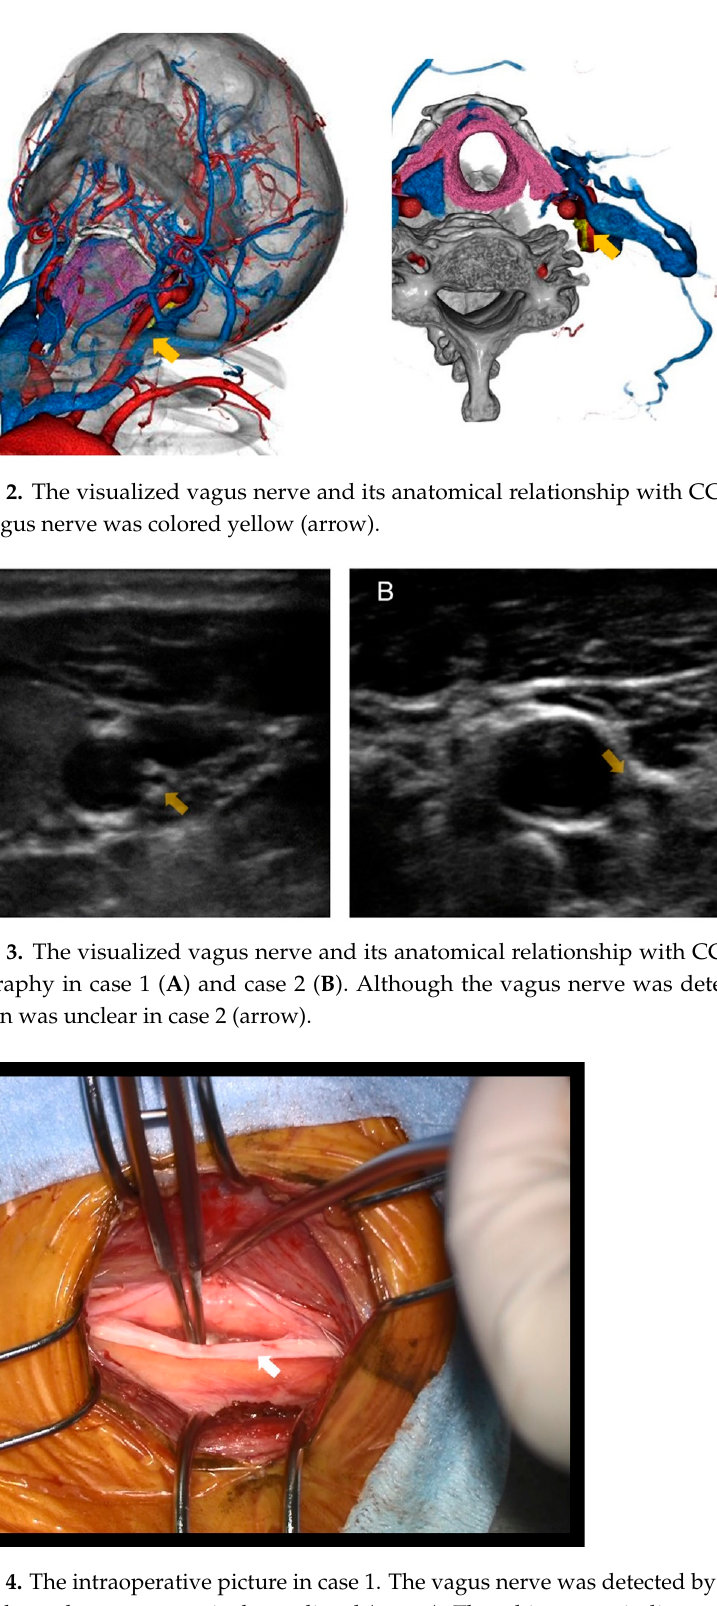
Figure 1. The visualized vagus nerve and its anatomical relationship with CCA and IJV in case 1. The vagus nerve was colored yellow in this figure (allow). The sternocleidomastoid muscle, CCA, and IJV were colored purple, red, and blue, respectively.